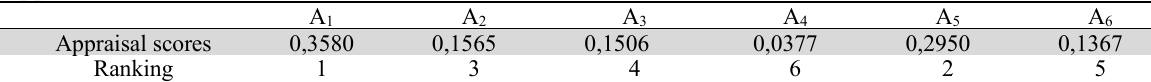
Appraisal scores of tractors